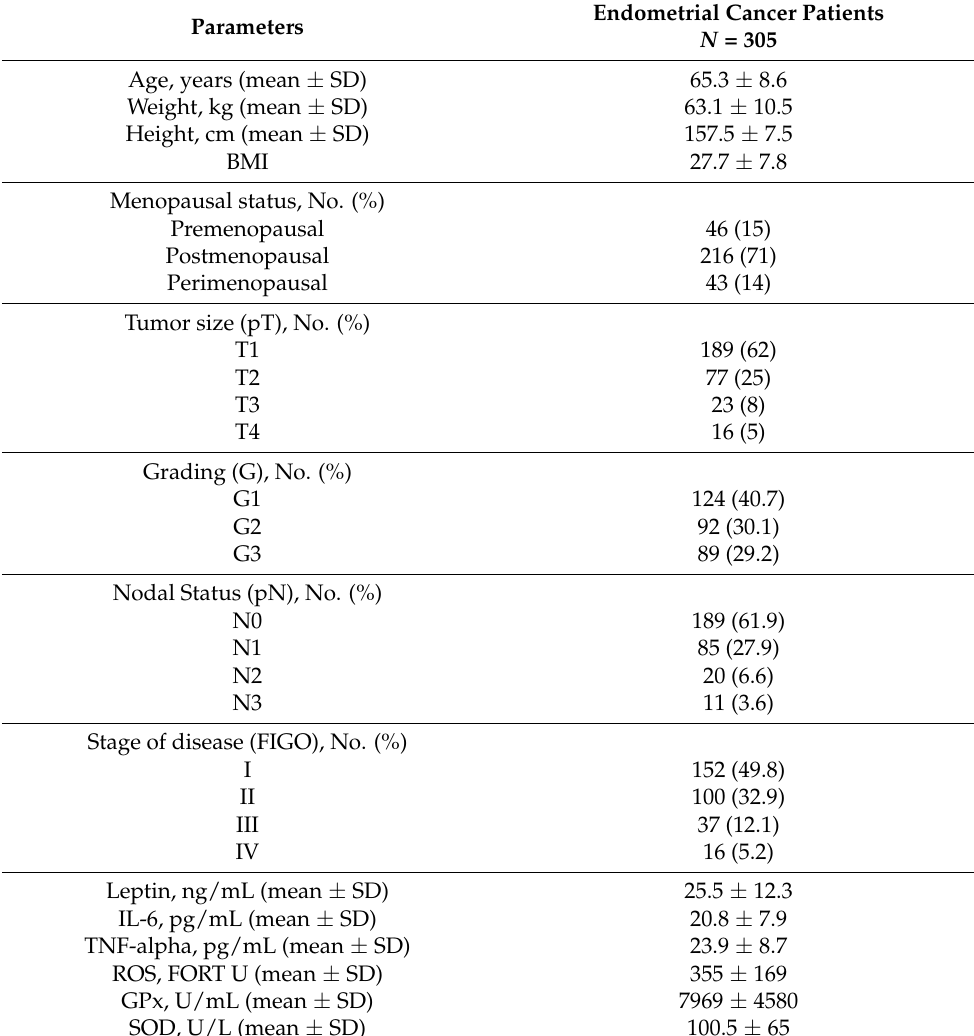
Table 1. Baseline anthropometric and laboratory characteristics of endometrial cancer patients and healthy